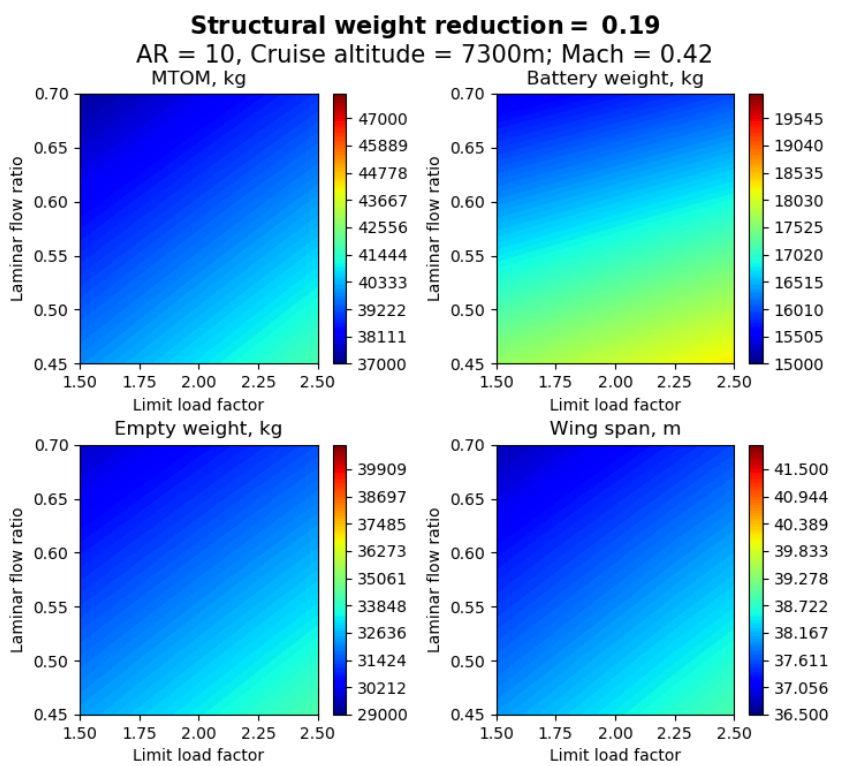
Figure 19. Sensitivity of aircraft characteristics to changes in technology levels at Structural weight reduction of